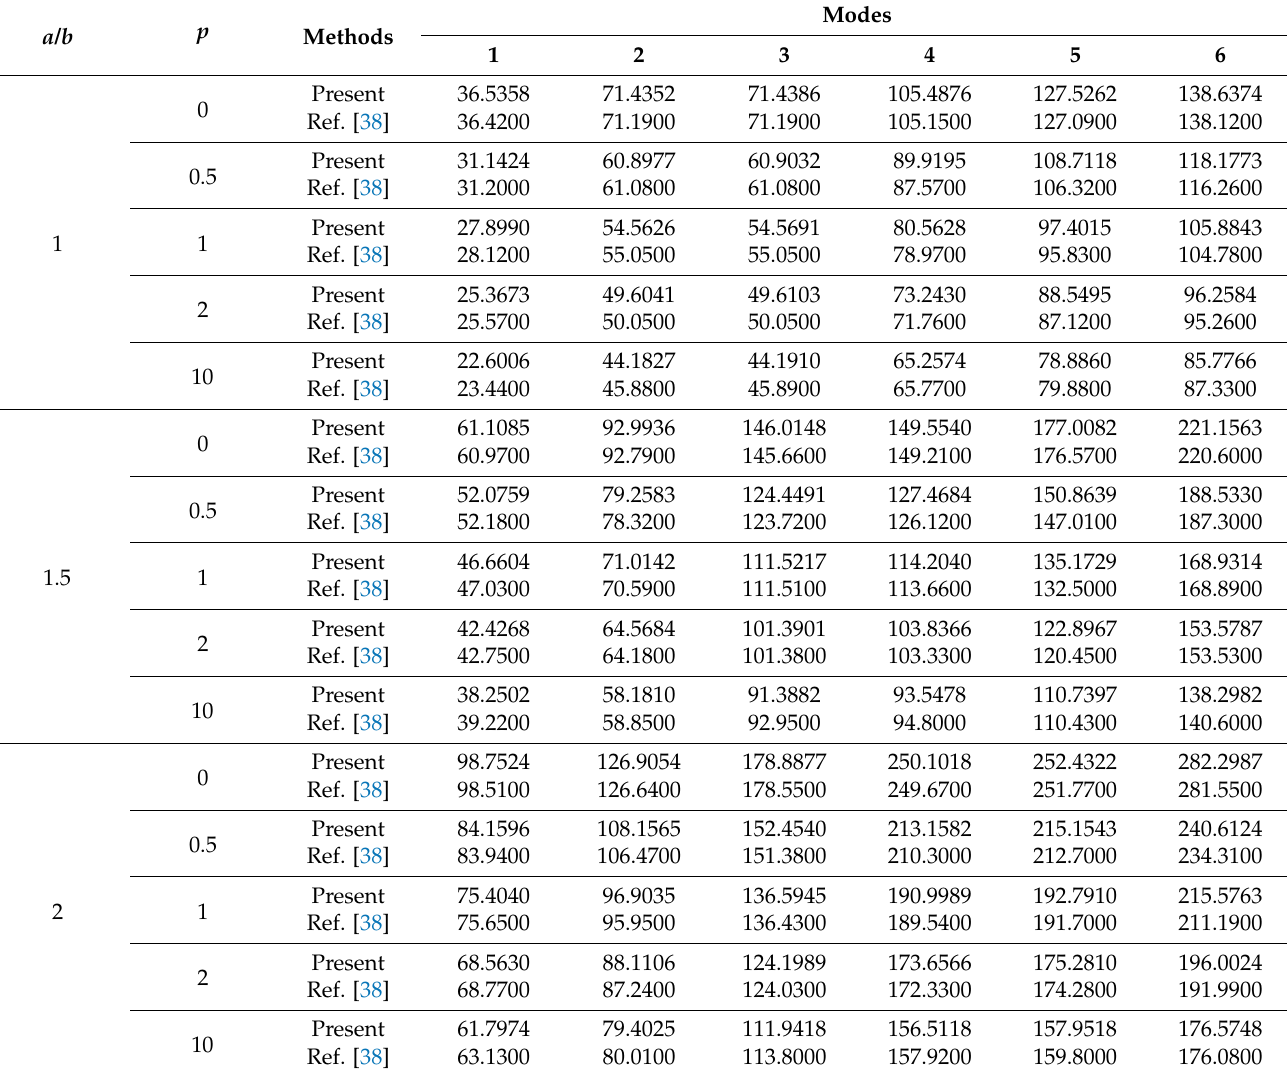
Table 4. The first six non-dimensional frequency parameters of FGMs rectangular plate with central circular cutout under